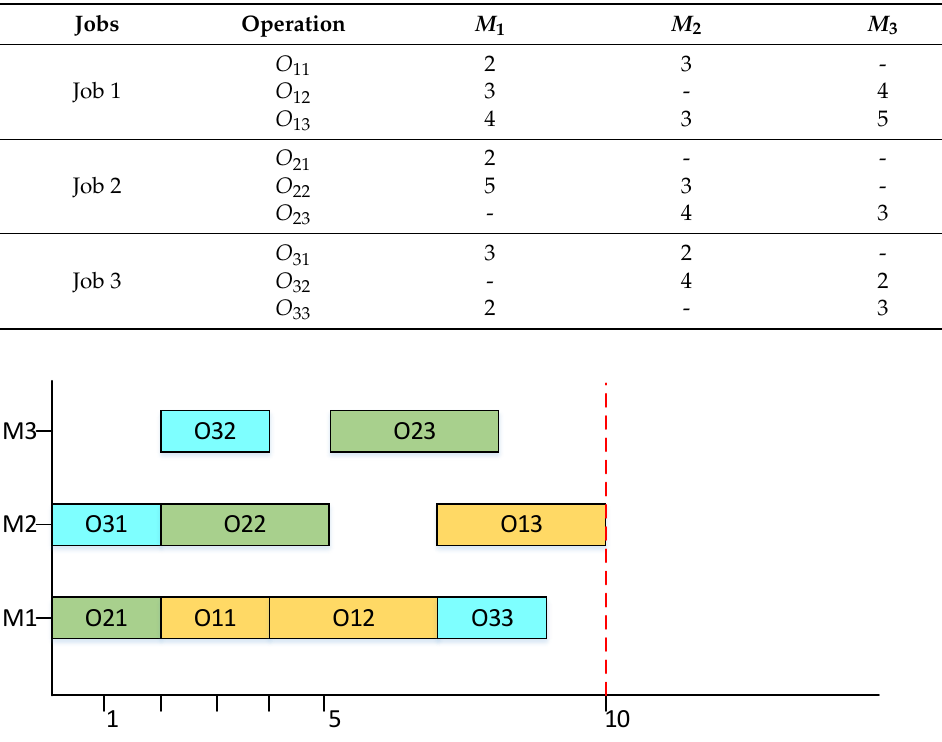
Figure 1. Scheduling scheme of Table